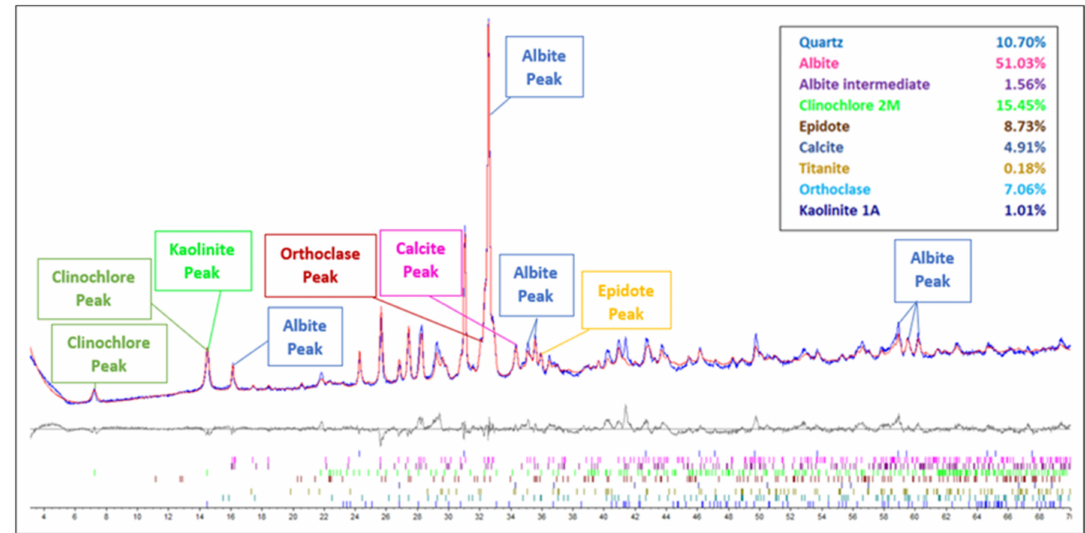
Figure 15. XRD pattern for the geopolymer activated with 100%